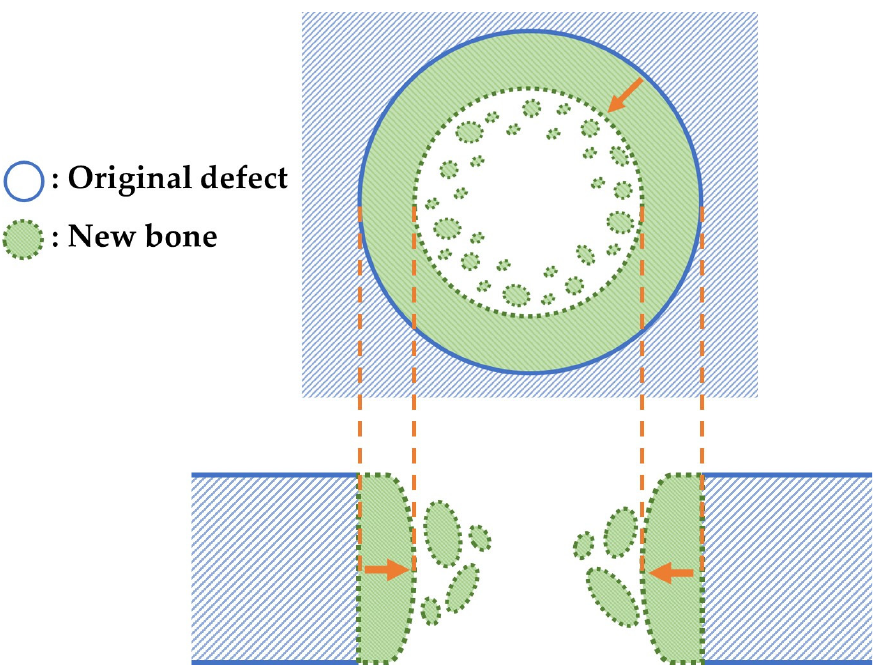
Figure 3. Top and cross-sectional views of new bone formation in a cranial bone defect. Note: the original defect area is denoted by solid lines. The extended bone area is denoted by broken lines and green color.